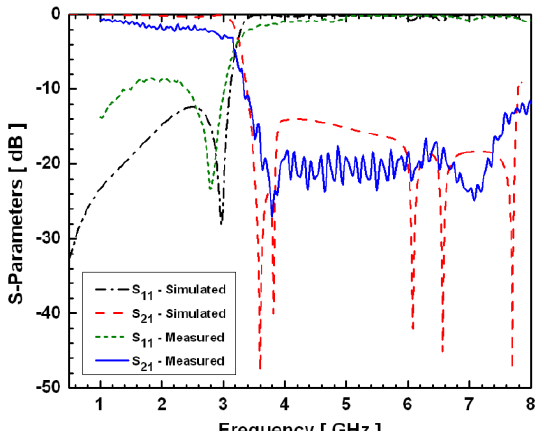
Fig. 5: Simulation and measured results of microstrip low pass filter